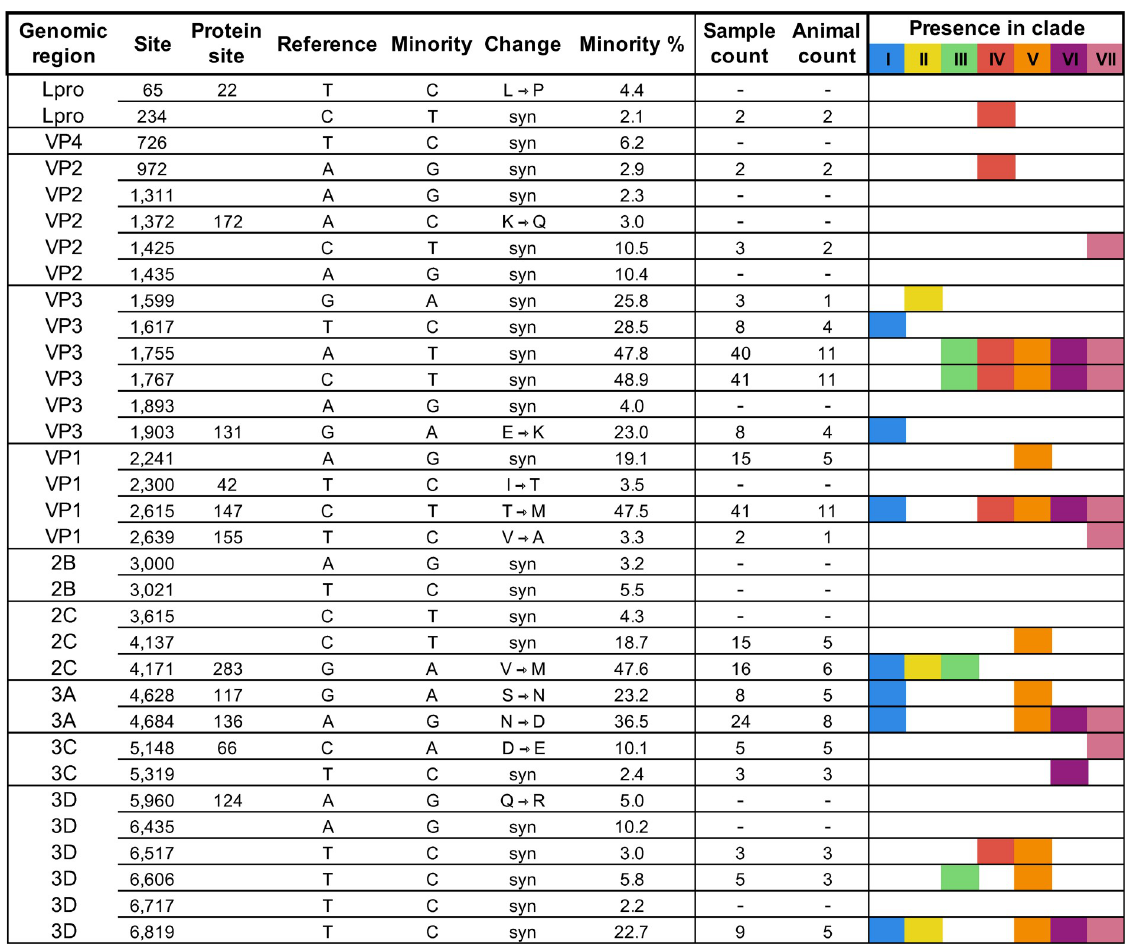
Fig 1. Subconsensus variants present above 2% frequency in inoculum ultra-deep sequencing. Reference is the consensus sequence of the inoculum and minority represents the polymorphic base at each site. Nucleotide variation was not detected in inoculum 2A and 3B1-3 coding regions. Sample count indicates the number of sample consensus sequences (of 52 total) that encoded each nucleotide found at the minority (2–49%) level in the inoculum deep sequence. Animal count indicates the number of individual hosts that provided sequences with these variants of the 13 total. If no value is indicated (-), no sample sequence encoded the inoculum’s minority nucleotide at the consensus level. Roman numerals and colors indicate the presence of each specific site change in at least one clade member as described in Results: Phylogenetic Associations.